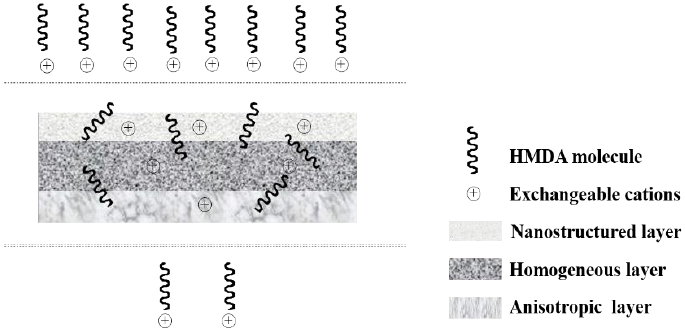
Figure 12. The behaviors of the permeation of HMDA molecules and exchangeable cations in mud cake.